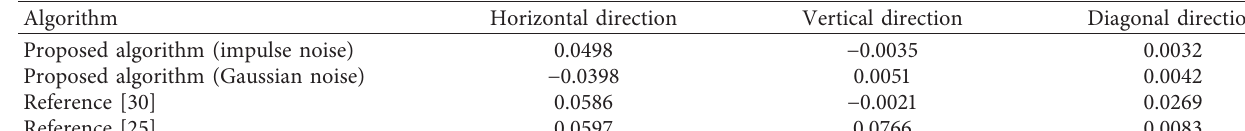
Table 5: Correlation between adjacent pixels of cipher text image.